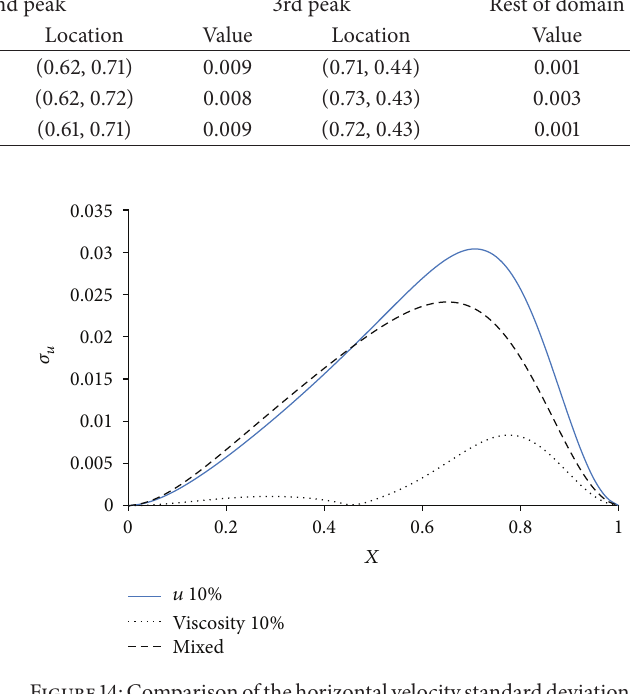
Figure14:Comparisonofthehorizontalvelocitystandarddeviation at the horizontal midline (𝑦 = 0.5) for different random